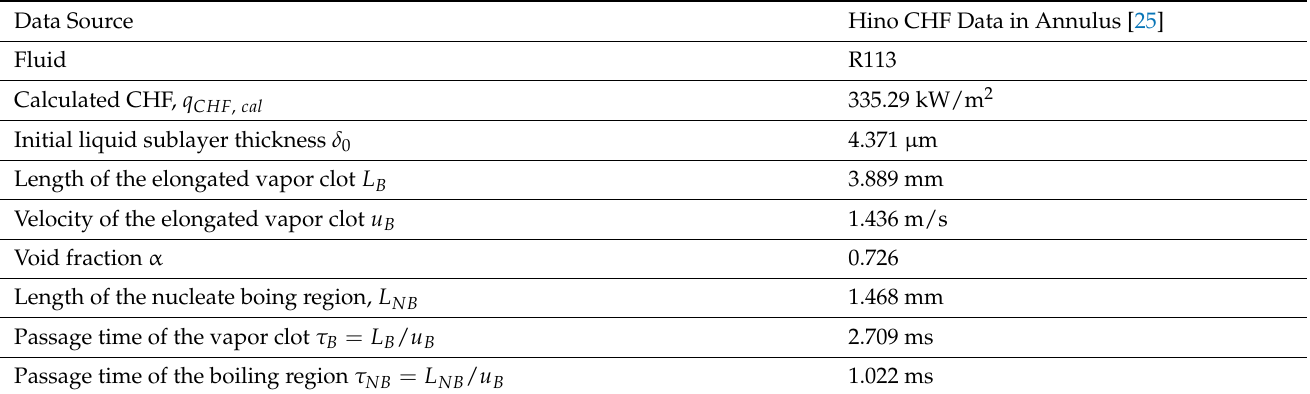
Table 2. Predicted CHF results for the analysis case.